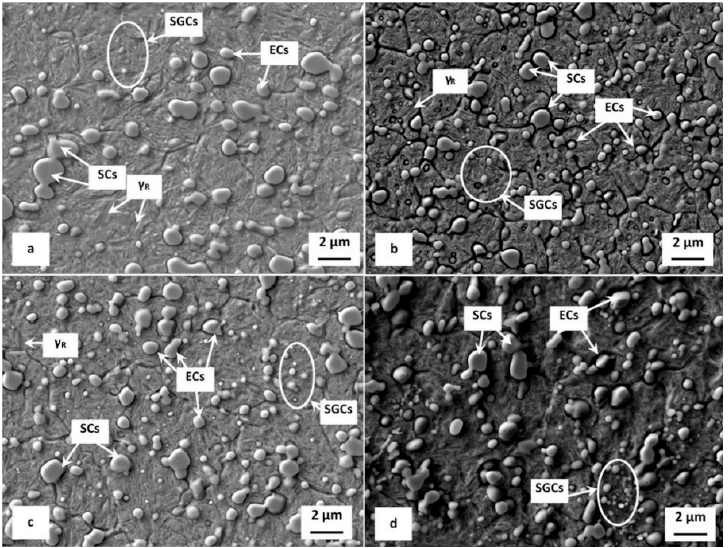
Figure 3. Typical SEM micrographs showing the microstructure of specimens after tempering at 170 ◦